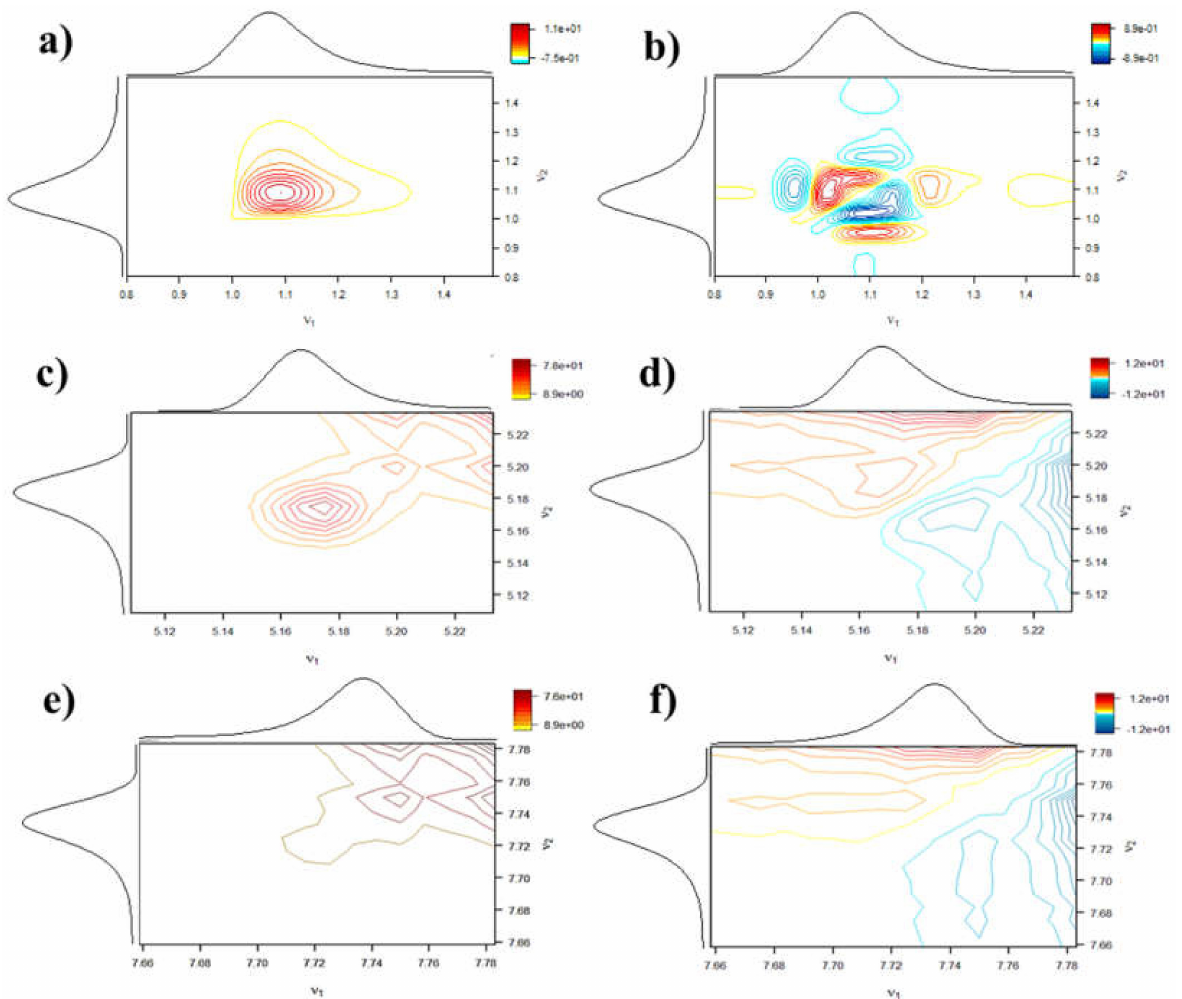
Figure 4. 2D-corr analysis: ( a ) synchronous plot of peak 1, ( b ) asynchronous plot of peak 1, ( c ) synchronous plot of peak 2, ( d ) asynchronous plot of peak 2, ( e ) synchronous plot of peak 3, and ( f ) asynchronous plot of peak